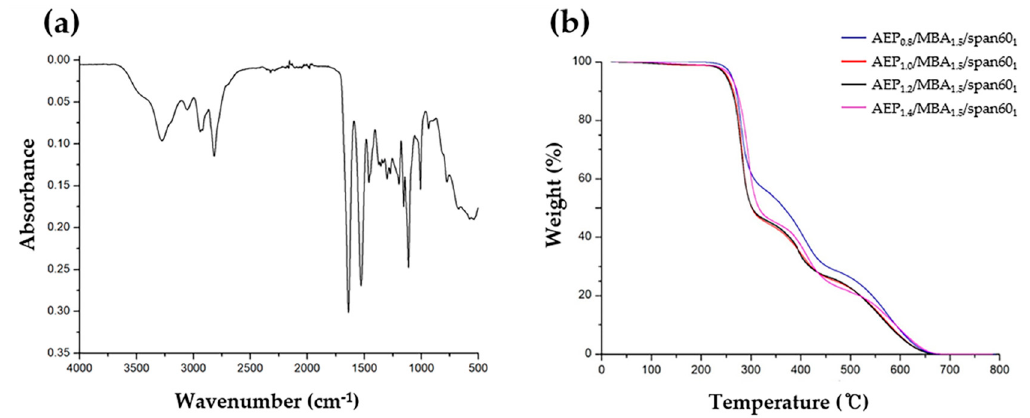
Figure 2. Attenuated total reflection infrared spectroscopy (ATR-IR) ( a ), and thermal gravimetric analysis (TGA) data ( b ). The ATR-IR sample was AEP 1.2 / MBA 1.5 / span60 1 in ( a ).